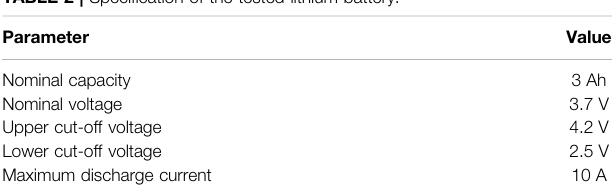
TABLE 2 | Speci fi cation of the tested lithium battery.